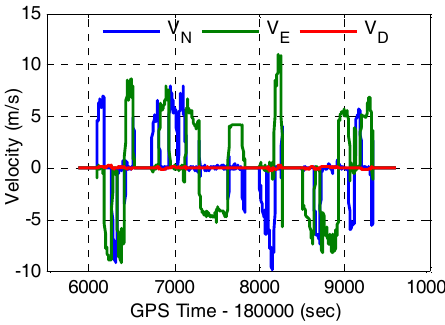
Figure 3. Velocity of the vehicle in the field test.